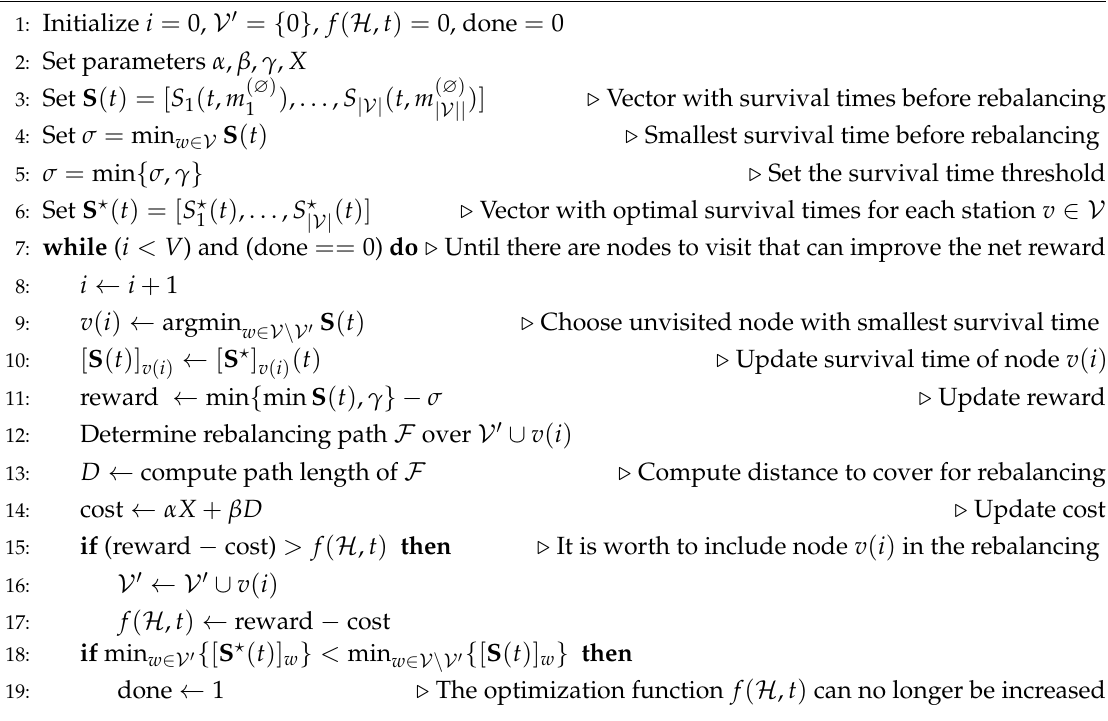
Algorithm 1 Rebalancing